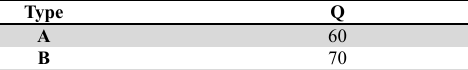
Vehicle properties